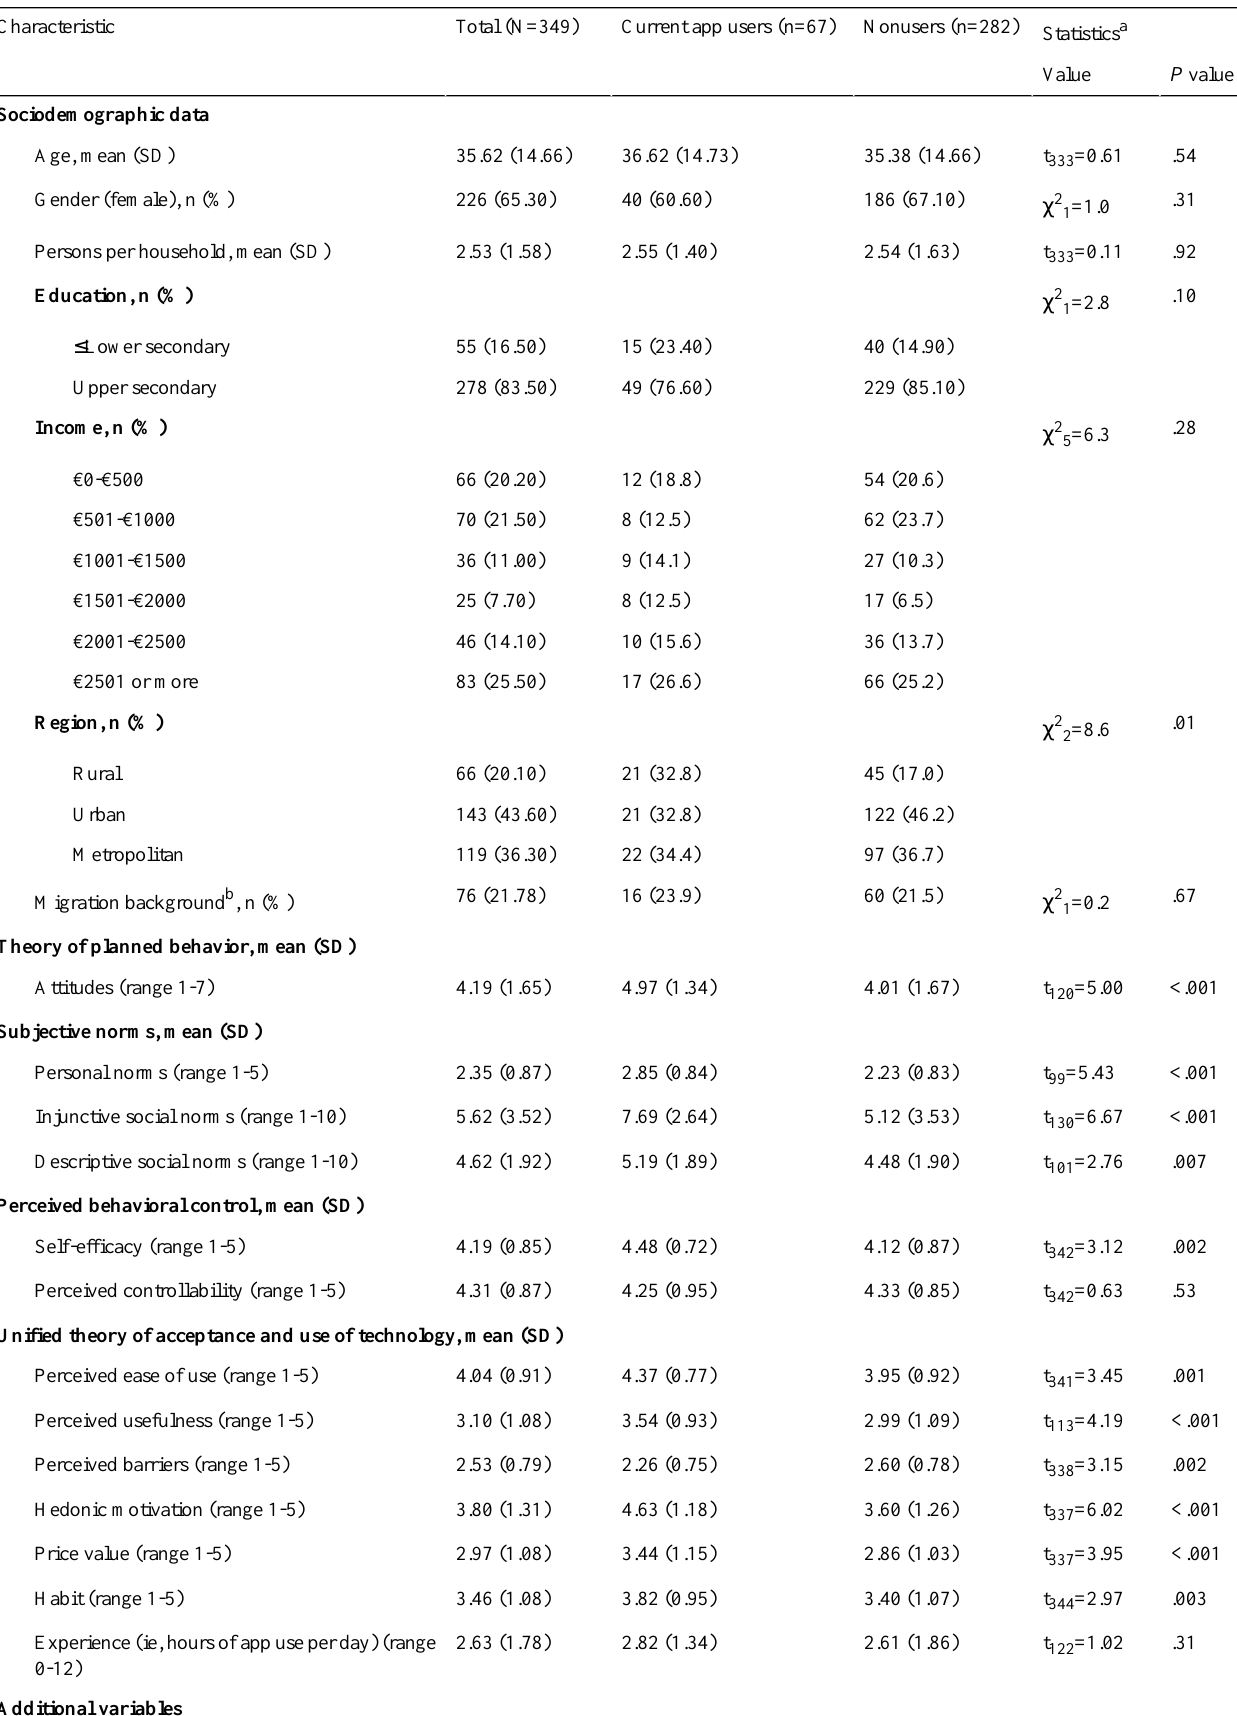
Table 1. Descriptive statistics comparing current users and nonusers of a COVID-19 contact tracing